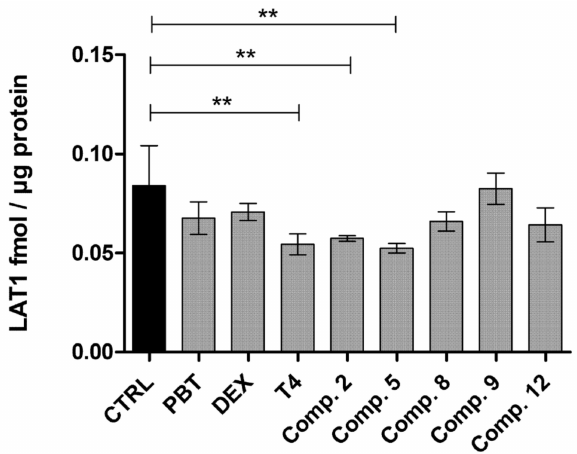
Figure 3. Quantitative protein levels of LAT1 normalized to a housekeeping protein Na+ /K+ATPase and the total amount of protein in the sample. The results are expressed as mean ± SD ( n = 3) and the asterisks denote a statistically significant difference, ** p < 0.01, one-way ANOVA, followed by Tukey’s test. The abbreviation PBT denotes phenobarbital and DEX dexamethasone.